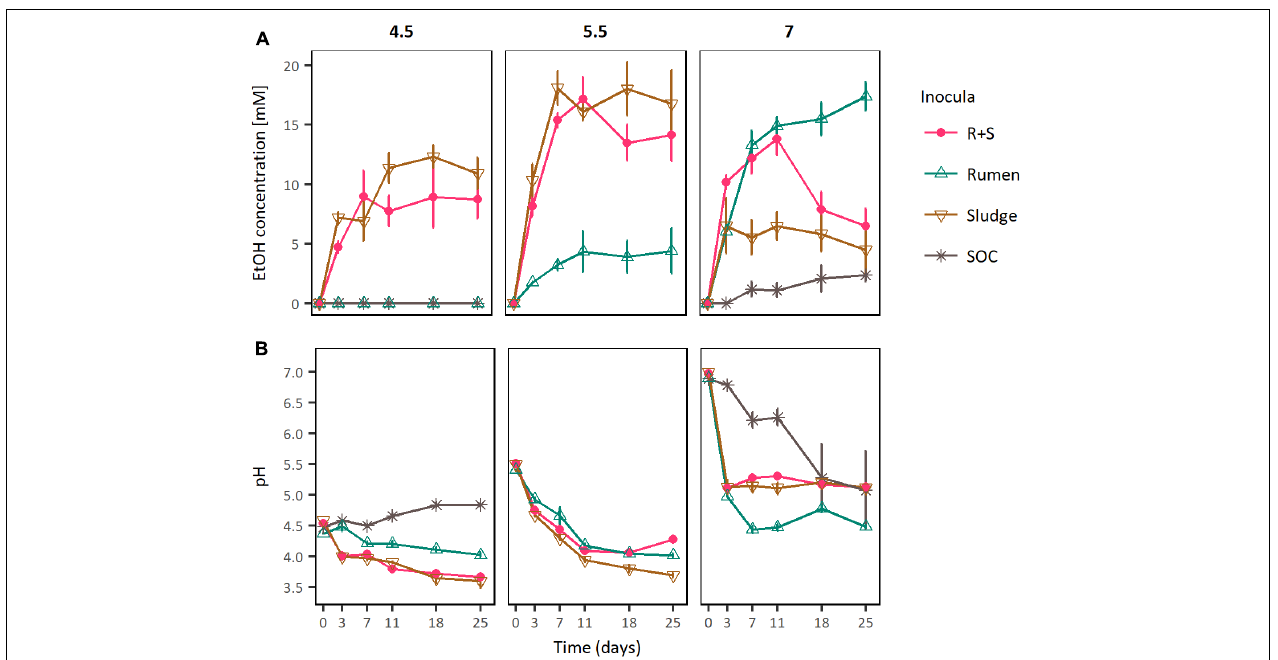
FIGURE 3 | (A) EtOH production profiles and (B) pH curves of rumen, sludge, and R + S incubated at a range of initial pH. SOC, substrate only control at initial neutral pH. The error bars represent the standard error of the mean (SE), n = 3.